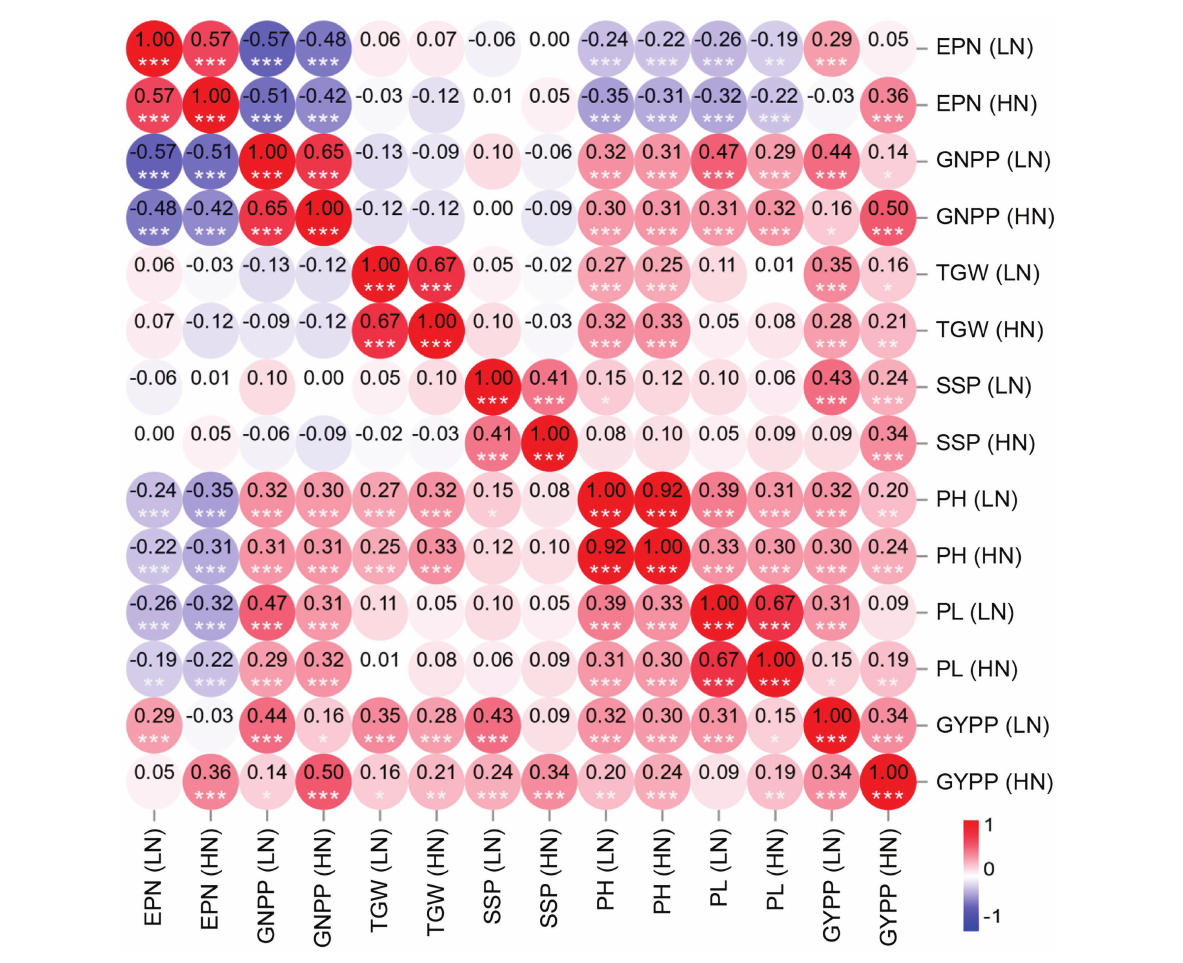
(Table 2). The additive effects of six of the seven QTLs for GNPP